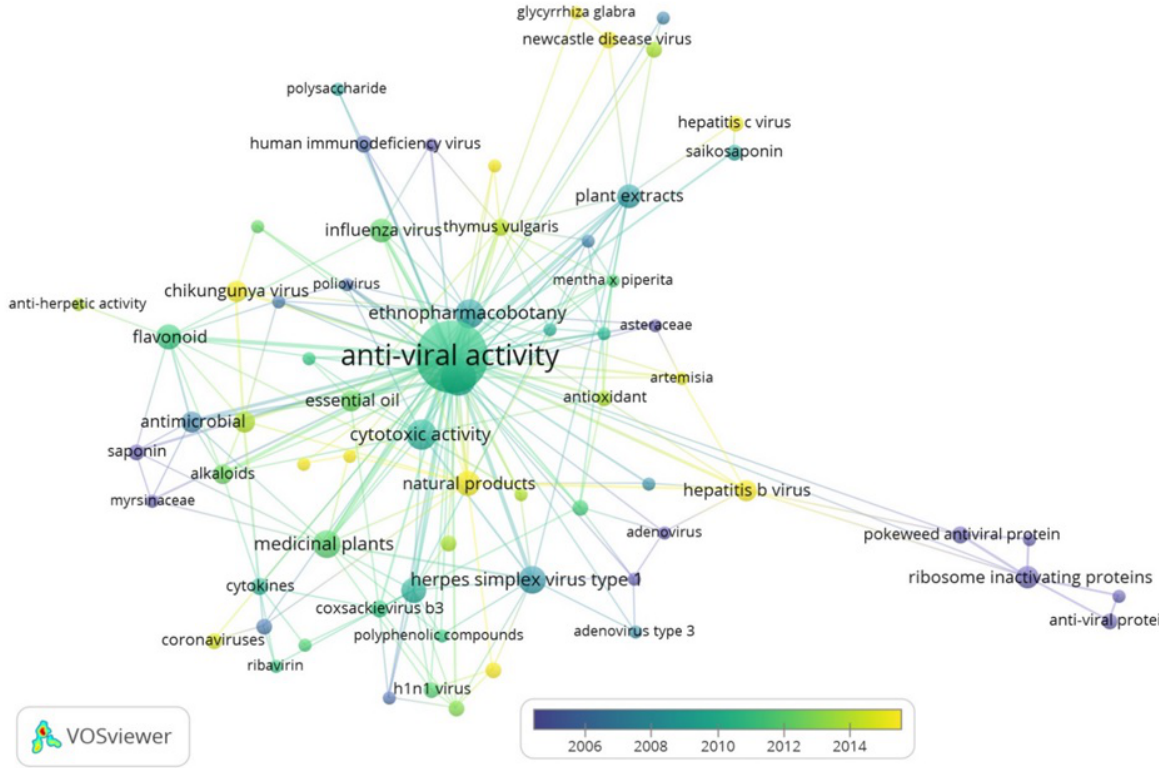
Figure 1. Schematic visualization of analyzed scientific data regarding the antiviral potential of natural plant resources. The visualization corresponds to a distance-based map, in which the space